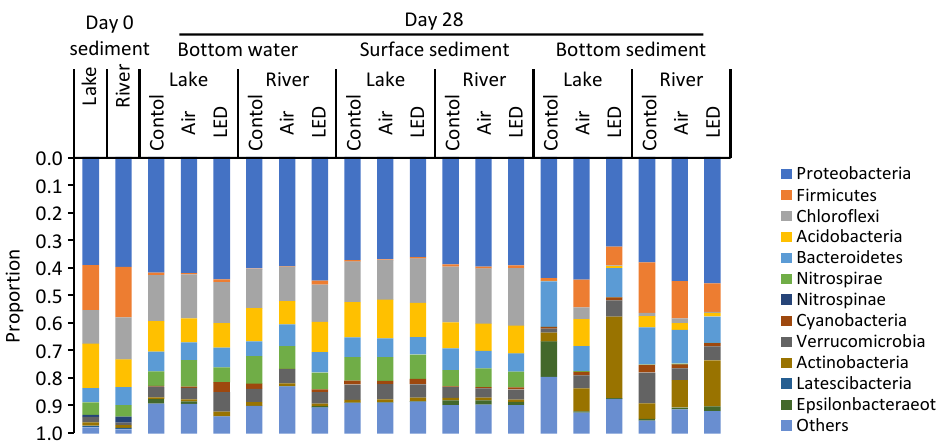
Figure 6. Relative abundance of bacterial species at the phylum level (a sequencing result of V3–V4 regions in 16S rRNA genes) in 18 water and sediment samples.